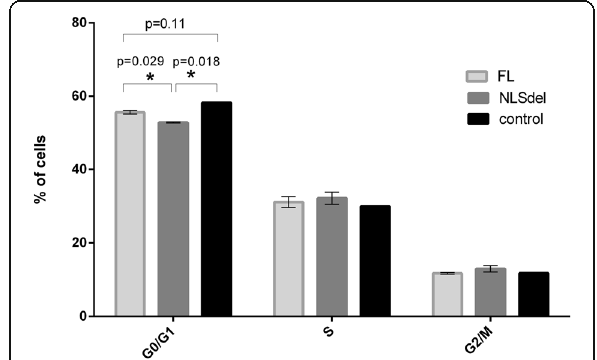
Fig. 2 Nuclear translocation of syndecan-1 affects the cell cycle distribution of fibrosarcoma cells. Cells transfected with the full-length (FLs1) or syndecan-1 lacking the nuclear localization signal (NLSdel) and empty vector (empty) were assayed with propidium iodide staining followed by flow cytometry, at 48 h after cell seeding. Columns represent the mean percentage±SD (n=3) of cells in the indicated phase of the cell cycle. Cells accumulated in the G1 phase in the presence of nuclear syndecan-1 compared to the deletion mutant. * p values were calculated using the paired